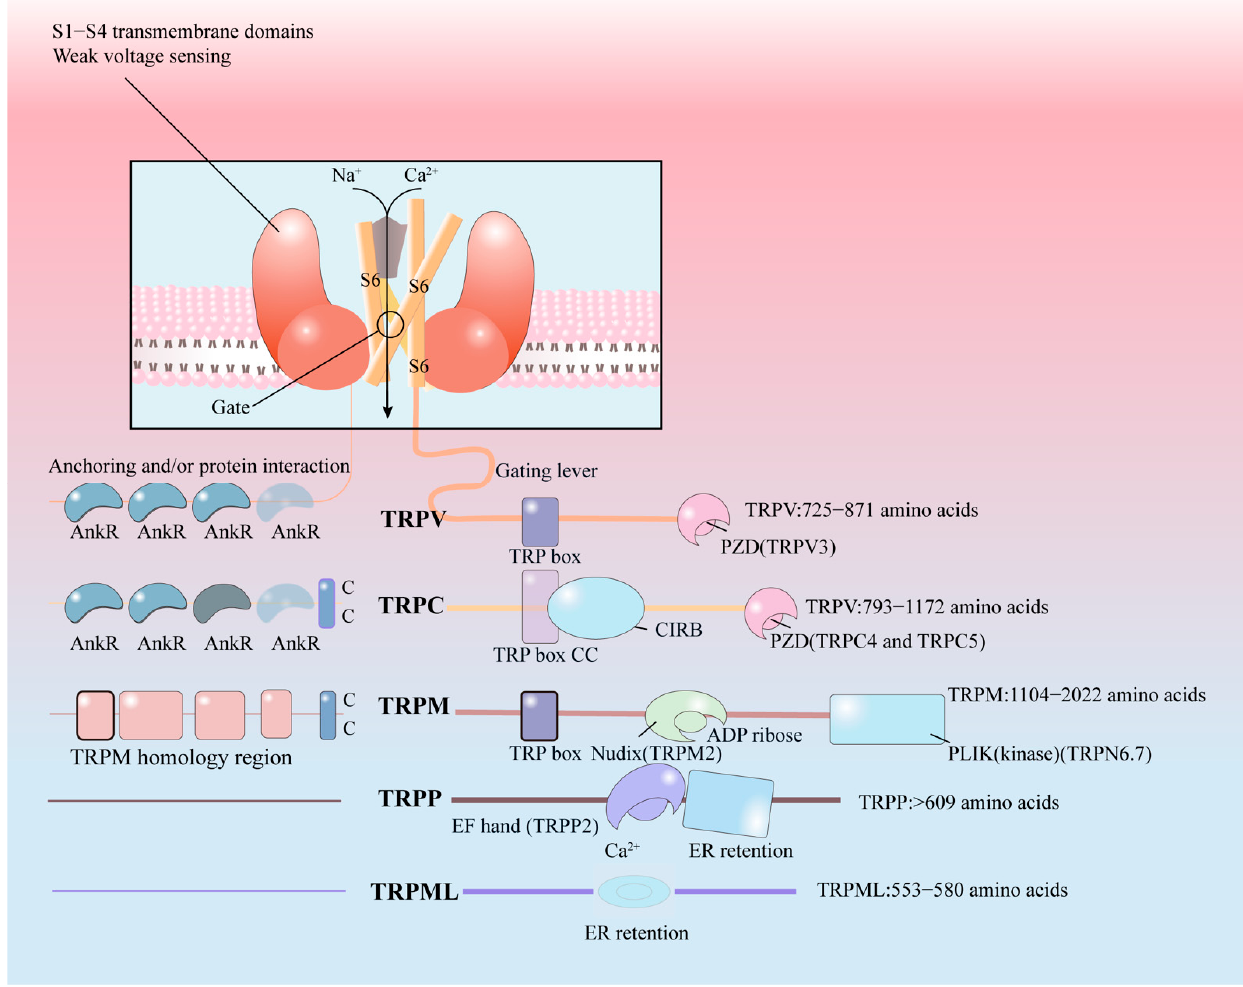
Figure 2. The TRP channels are composed of six transmembrane-spanning domains (S1–S6) that have a pore-forming loop connecting S5 and S6 as well as N and C termini situated intracellularly. In the S6 region, there are some structural differences between thermo-TRPs.